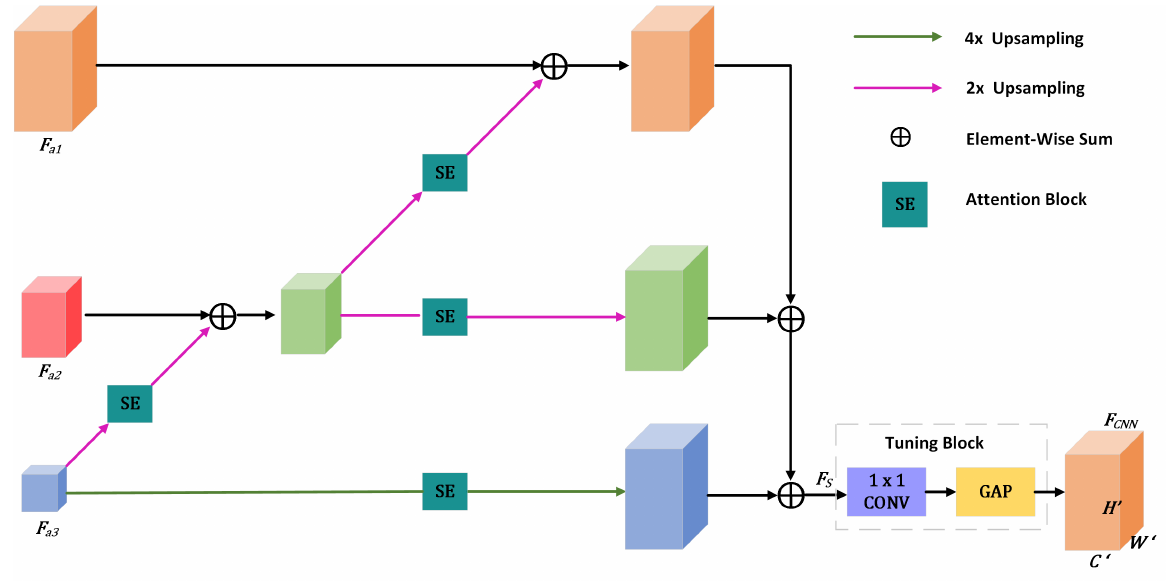
Figure 4. Framework of MsFFM. Features with smaller resolution are upsampled and then provided as the input to the channel attention block. The channel-optimized upsampled features are added element-wise to the adjacent features with higher resolution. Finally, we merge the all-upsampled feature map to further aggregate information, and the tuning block is adopted to refine the fused multi-scale feature. In this figure, the magenta arrow and green arrow represent the two-times upsampling operation and four-times upsampling operation, respectively, ⊕ denotes the elementwise sum operation, and F CNN is the feature map after multi-scale